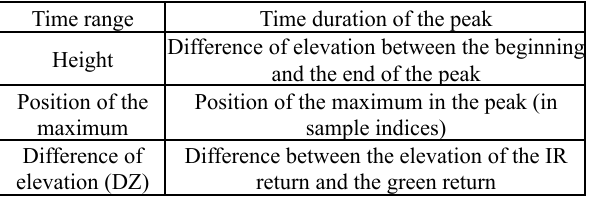
Table 2. Definition of the features extracted in the waveforms.